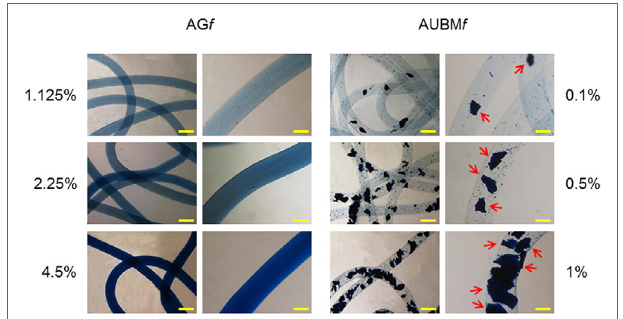
FigUre 2 | Distribution of gelatin and UBM in composite microfibers. Different amounts of gelatin (1.125, 2.25, and 4.5% w/v) or UBM (0.1, 0.5, and 1% w/v) were added to the alginate solution, respectively. Microfibers containing different amount gelatin/UBM were stained with Coomassie Blue Brilliant. The presence and distribution of UBM particles are indicated by arrows. Bar corresponds to 1 mm in lower magnification photomicrographs and to 400 µm in higher magnification